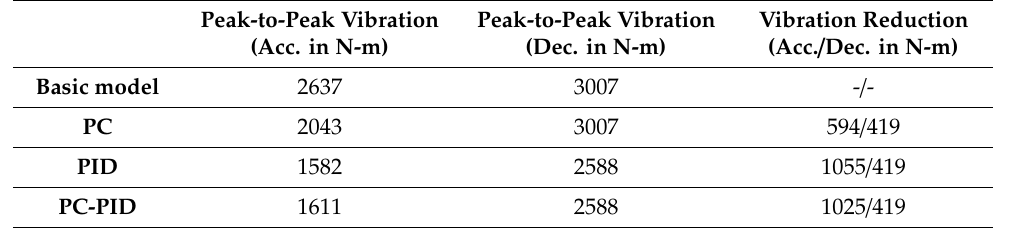
Figure 9. Vehicle half-shaft torque during deceleration in time domain. Table 1. Comparison of the vibration deduction results of each control method and basic model (original) in the time domain.